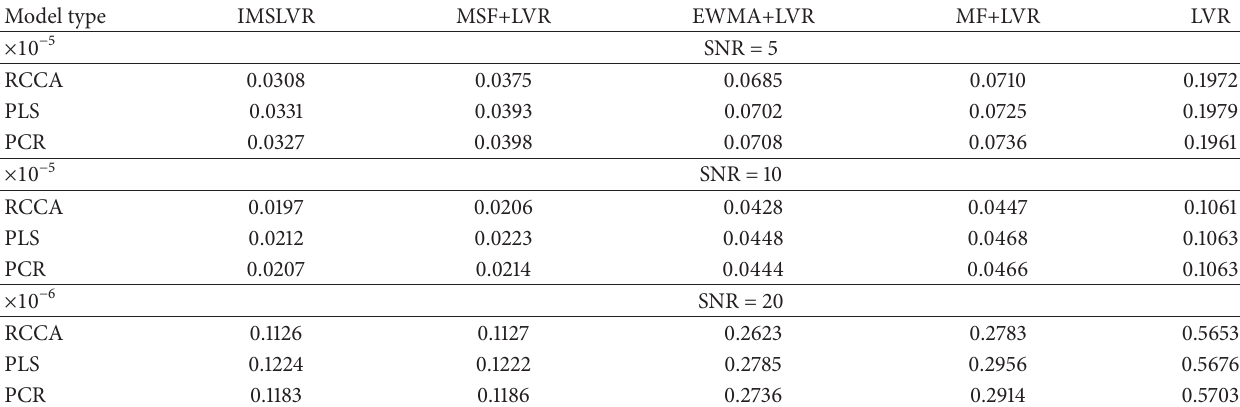
Table 4: Comparison of the Monte Carlo MSE’s for 𝑥 𝐵 in the simulated distillation column example.